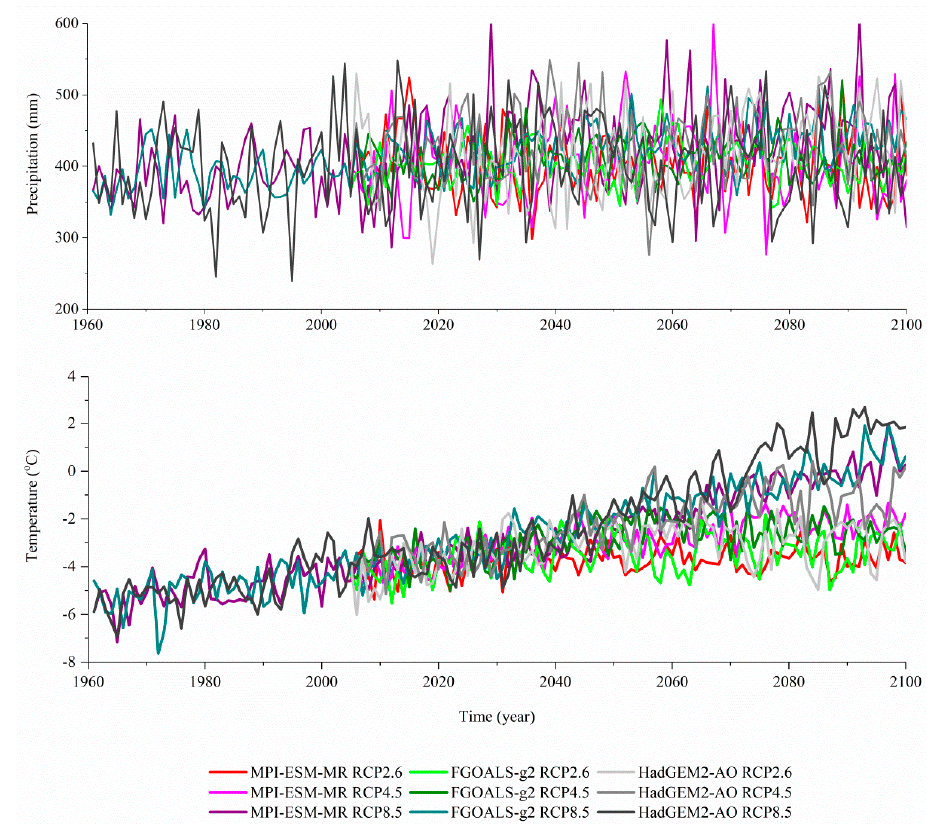
Figure 7. The bias corrected projected annual precipitation and temperature time series during the period from 1961 to 2100.